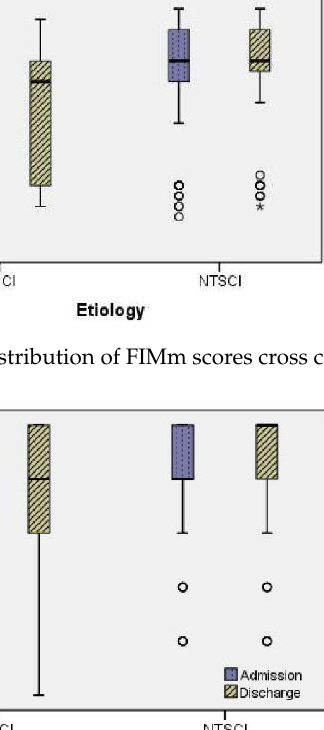
Figure 4. The distribution of FIMm scores cross categories of etiology (T-SCI/NT-SCI).